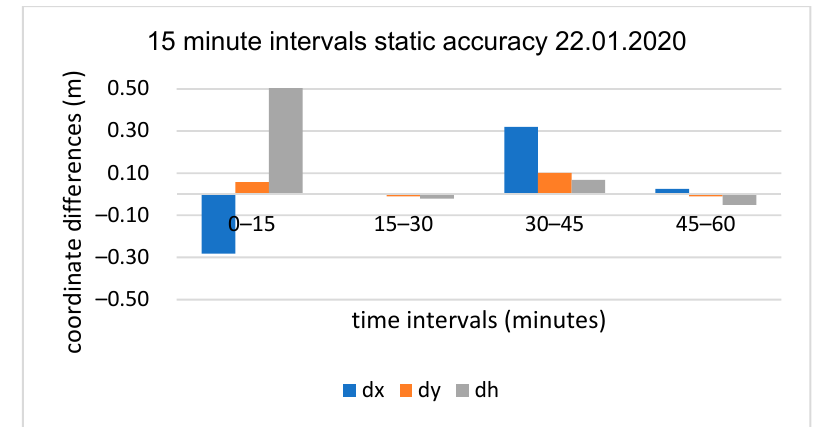
Figure 13. 20 min sub-session positioning results for the second test, baseline OPNT–P30Pro (4 km). Figure 14. 30 min sub-session positioning results for the second test, baseline OPNT–P30Pro (4 km).